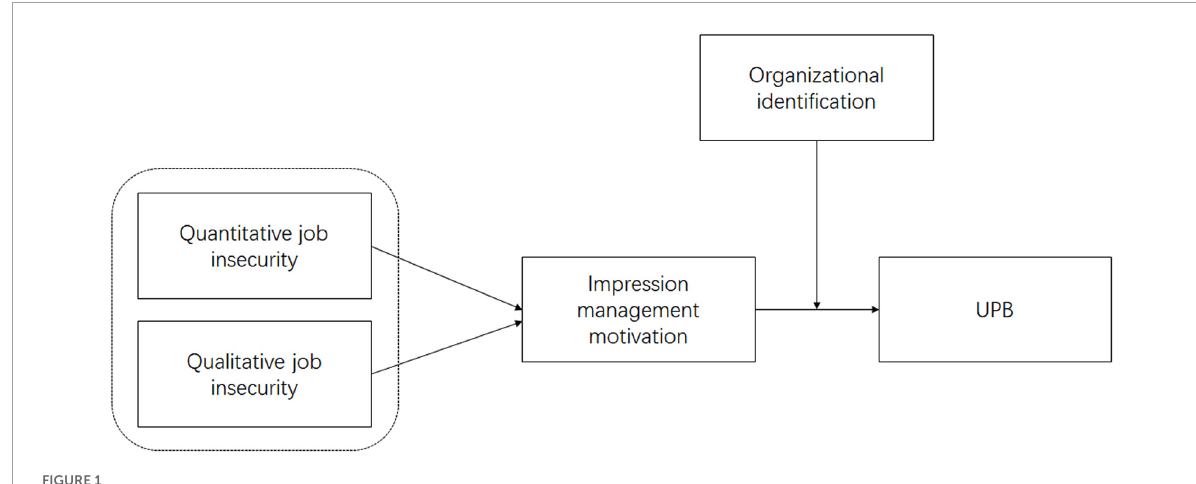
FIGURE1 Theoretical